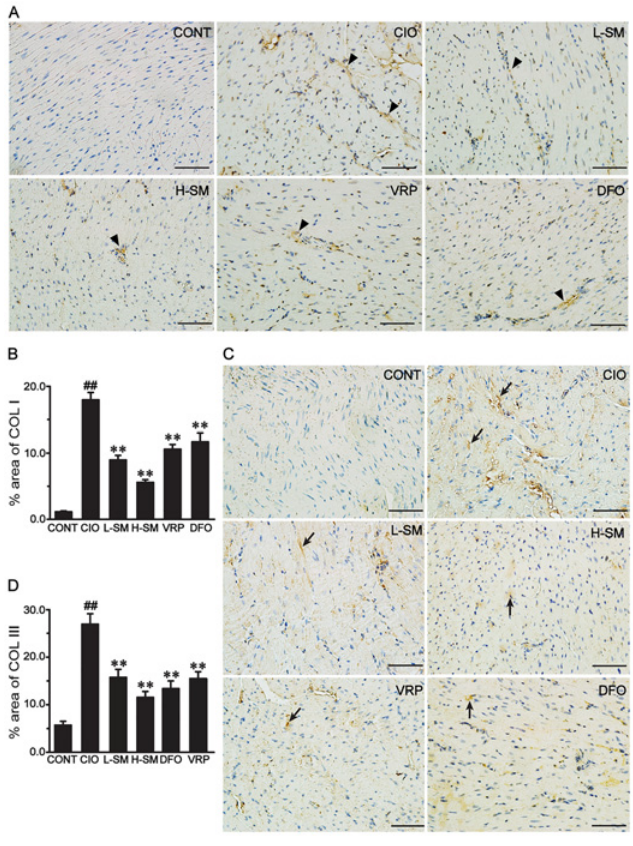
Fig 4. Effects of SM treatment on expression levels of COL I and COL III detected by immunohistochemistry. Representative microscopic photographs were obtained from each group. The morphological location and percent area of COL I expression (A and B, respectively) or of COL III expression (C and D, respectively) are shown. Positive expression of COL I (triangles) or COL III (arrows) is indicated, and the bar represents 50 μ m (original magnification, 400×). Values are means ± SEM. ## P < 0.01 vs. CONT group; ** P < 0.01 vs. CIO